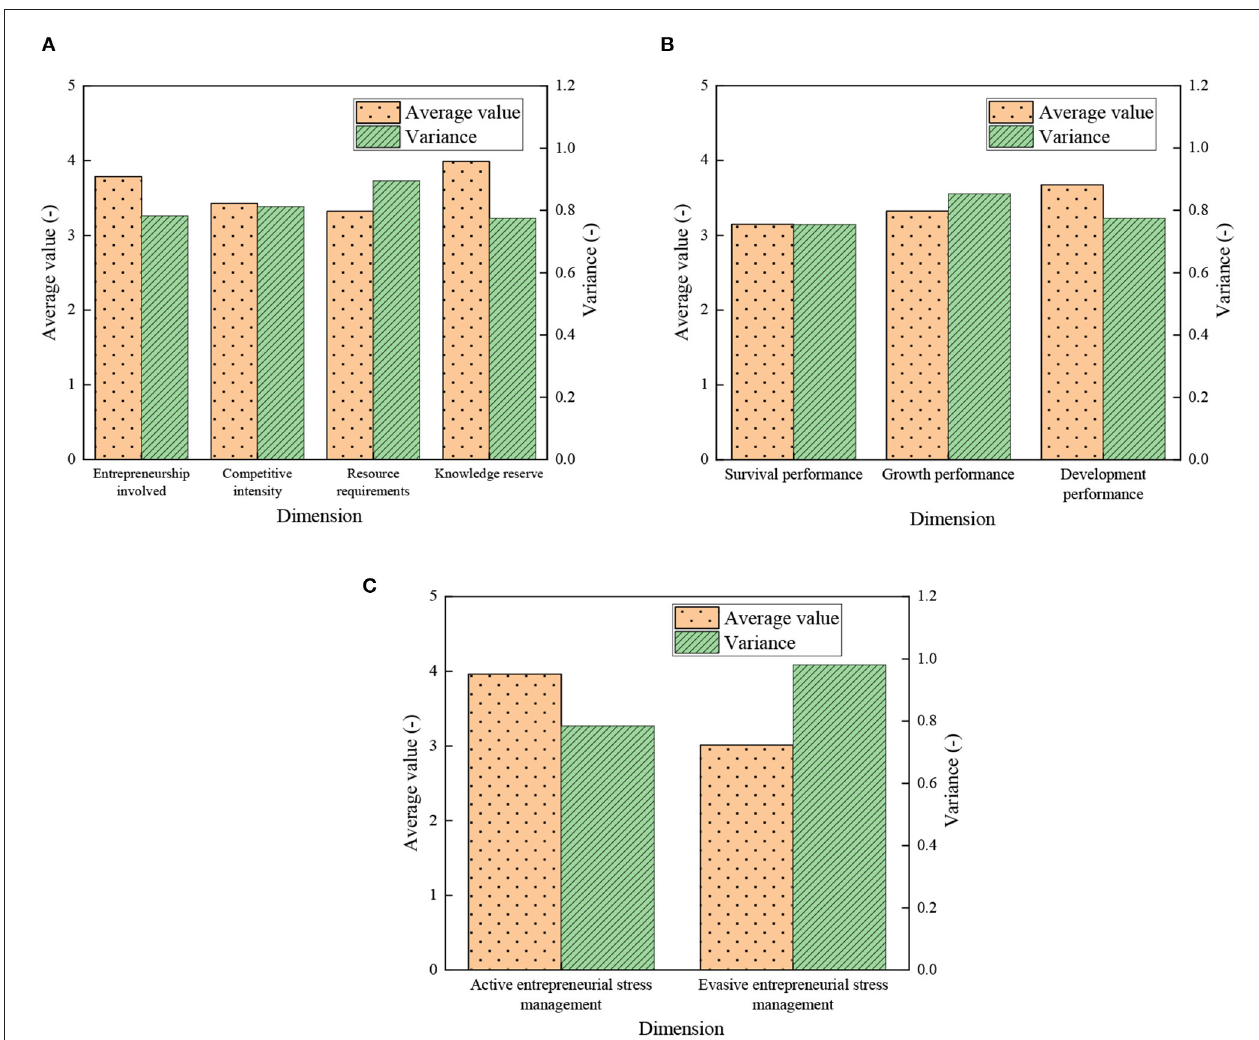
FIGURE 7 | Data statistics of psychological stress, stress management, and new venture performance of new venture entrepreneurs: (A) psychological stress statistics of new venture entrepreneurs; (B) the statistics of enterprise performance; and (C) the score statistics of psychological stress management scale.